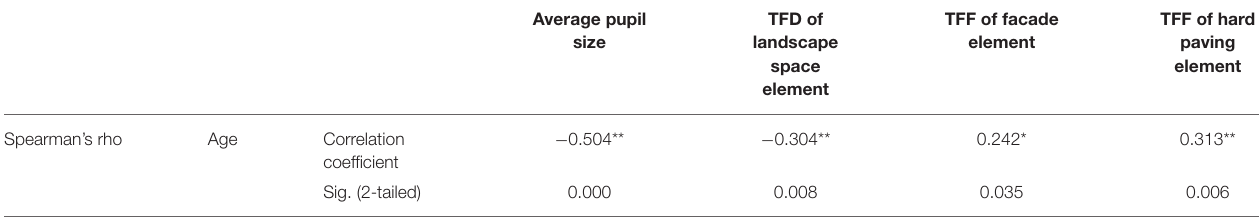
TABLE 7 | Correlations coefficient between age and EMM.